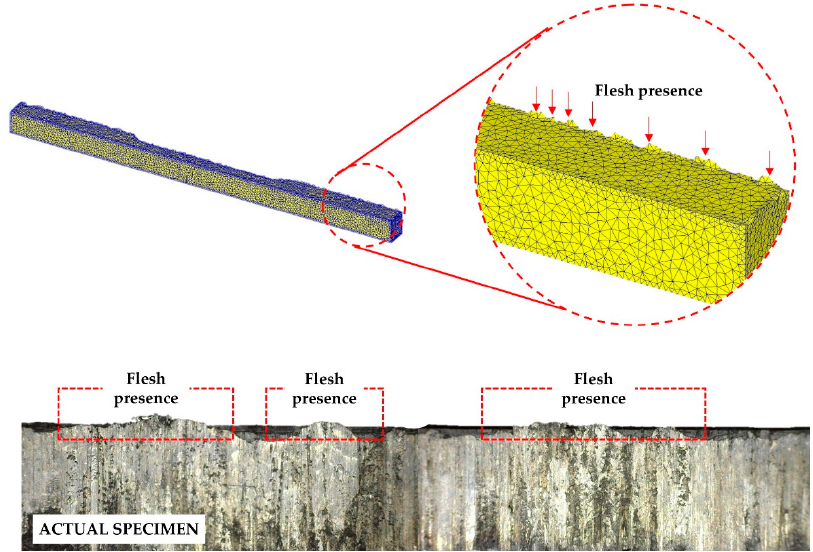
Figure 12. Flesh progression on the workpiece throughout the hot press forging simulation.